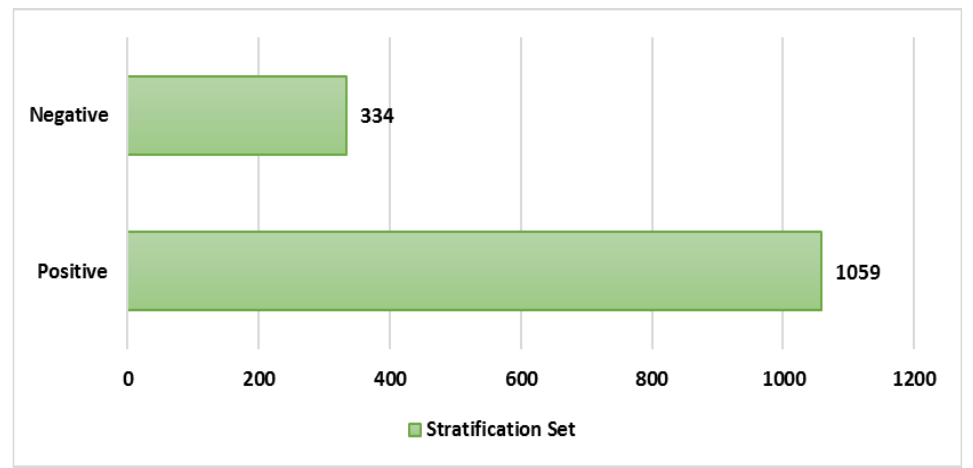
Figure 3. Number of Records used in Sentiment Analysis (n = 1393). Table 3. Performance metrics of MLSA with 5-fold cross validation. Model